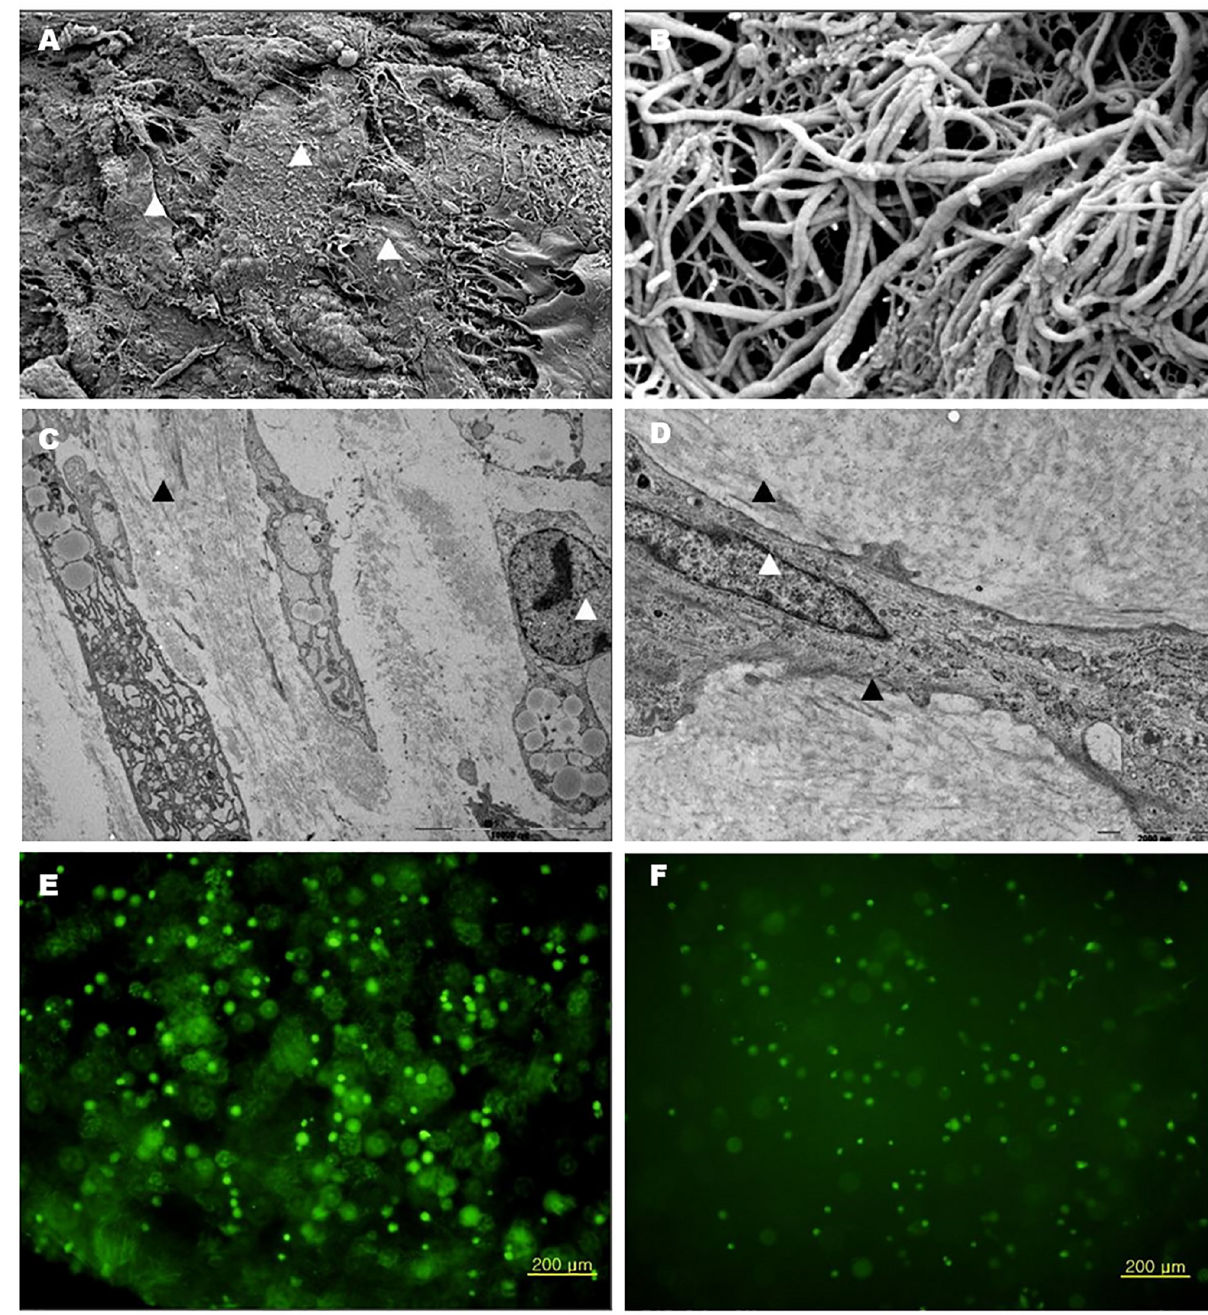
Fig 3. Scanning electron microscopy of TGF- β 1-transduced chondrocyte-atelocollagen mixture. (A), (B) TGF- β 1-transduced chondrocyte- atelocollagen mixture after 21 days of culture. A large number of cells surrounded the mixture bead and were in close contact with each other (white arrowhead). Profound fibers with striation, which is specific for collagen fiber, and formation of mesh structure for cell attachment were observed. Transmission electron microscopy of TGF- β 1-transduced chondrocyte-atelocollagen mixture: (C), (D) TGF- β 1-transduced chondrocyte-atelocollagen mixture after 21 days of culture. Numerous vesicles (white arrowhead) in the cytoplasm indicated the active secretory function of cells and production of proteoglycan granules and fibrillar collagens with striation (black arrowhead) for matrix formation. Biochemical staining of TGF- β 1-transduced chondrocyte-atelocollagen mixture: viable cells appeared green and dead cells appeared red after staining with calcein acetoxymethyl ester and ethidium homodimer. (E) At 48 h and (F) 7 days after fluorescent dye staining. Original magnification × 100.